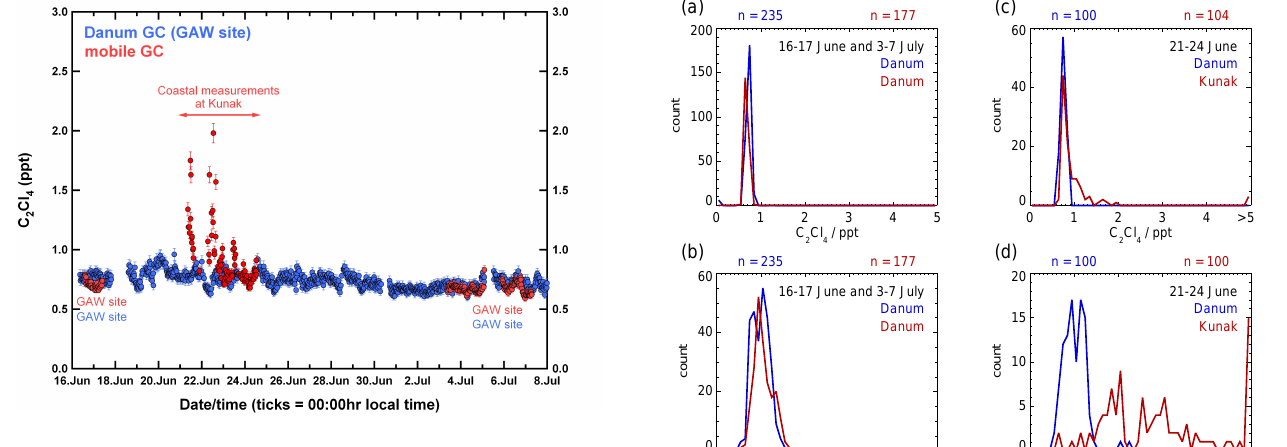
Fig. 2. Time series of measured concentrations of C 2 Cl 4 . The colour scheme means the same as in Fig. 1.